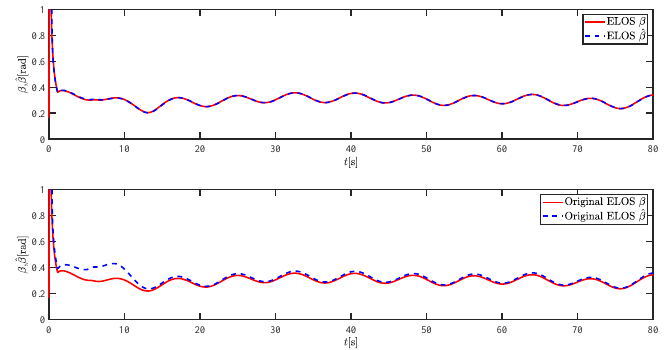
Figure 23. Along-track error x e and cross-track error y e at fast speed.